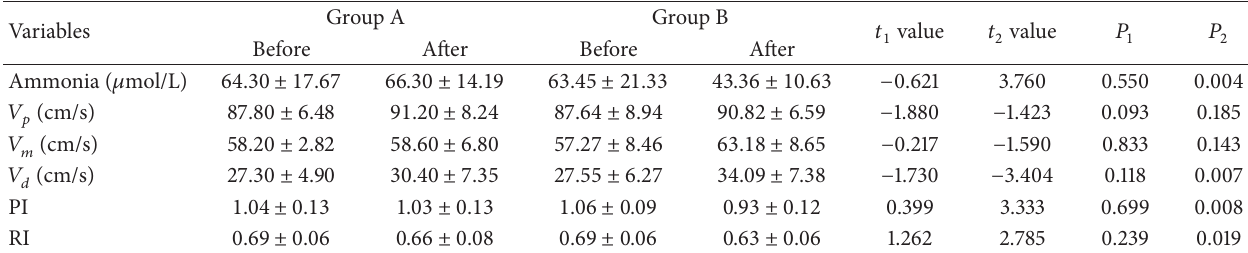
Table 6 indicates comparison of ammonia and TCD including 𝑉 𝑝 , 𝑉 𝑚 , 𝑉 𝑑 , PI, and RI between group A and B before and after treatment. 𝑡 1 and 𝑃 1 represent comparison before and after treatment in group A; 𝑡 2 and 𝑃 2 represent comparison before and after treatment in group B. Group A is the control group; group B is the treated group. Continuous data were compared using 𝑡 -test. 𝑃 < 0.05 means significant differences in an index before and after